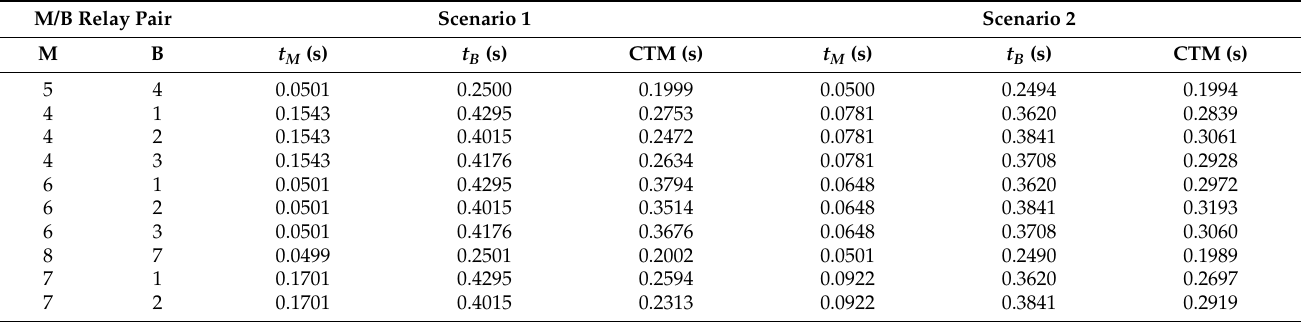
Table 7. Operating times of M/B relay pairs with their associated CTM values of the Agiba Network using Test Model